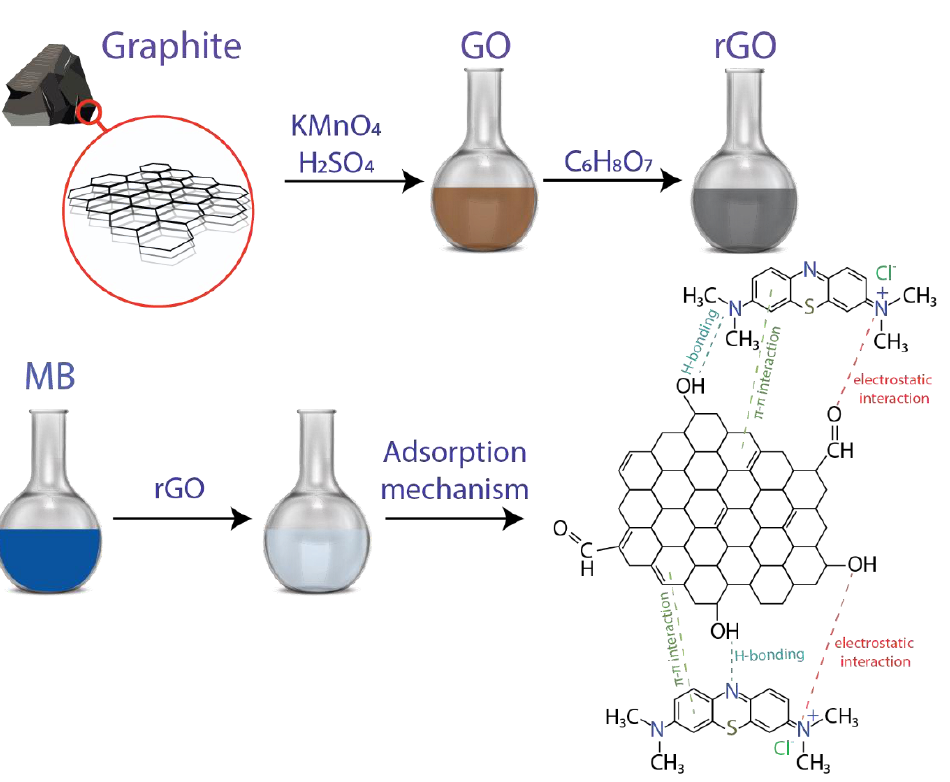
Figure 1. Schematic representation of the procedure and adsorption mechanism of methylene blue using reduced graphene oxide.